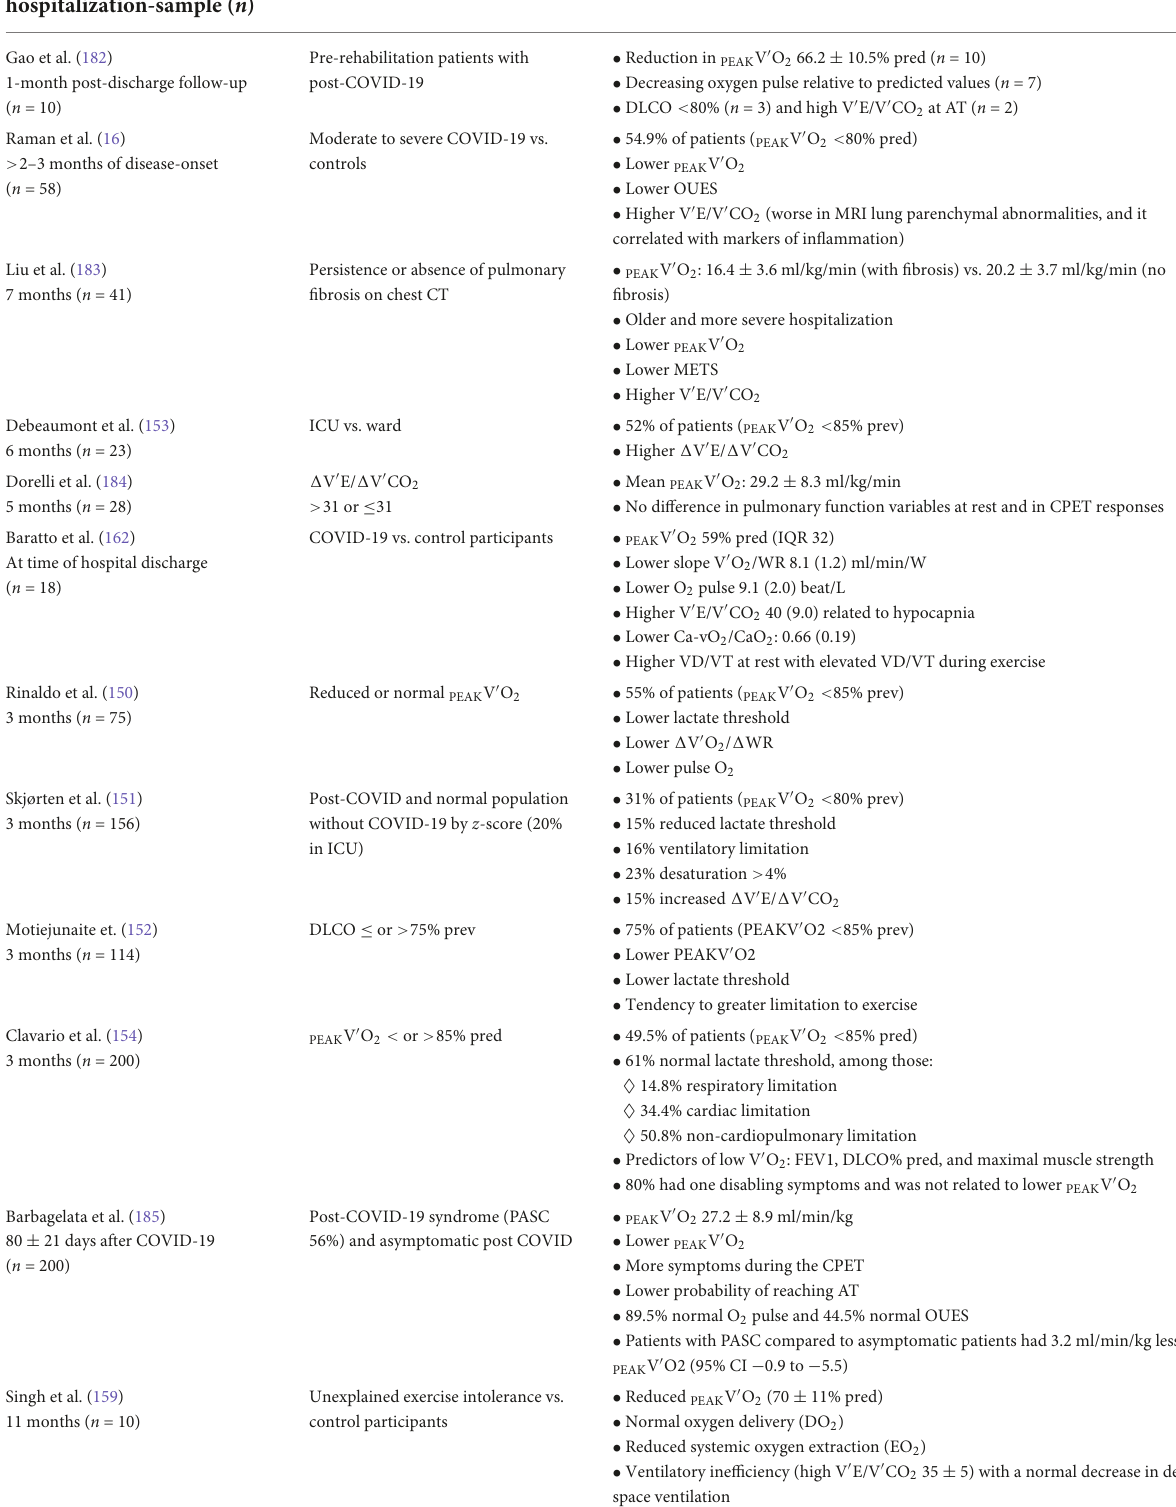
TABLE 2 Mechanisms of exercise intolerance in post-COVID